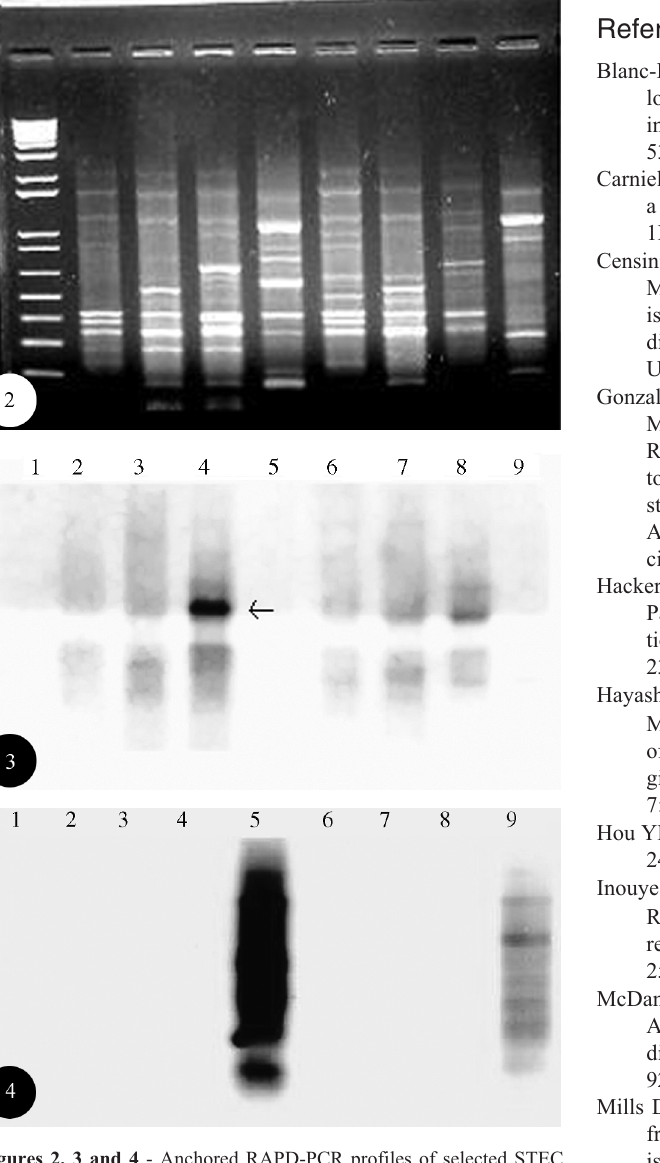
the 5end of pheU (913) and a random primer (r1 or r2). Samples of lanes 5 and 9 were amplified with a specific primer annealing to the 5end of